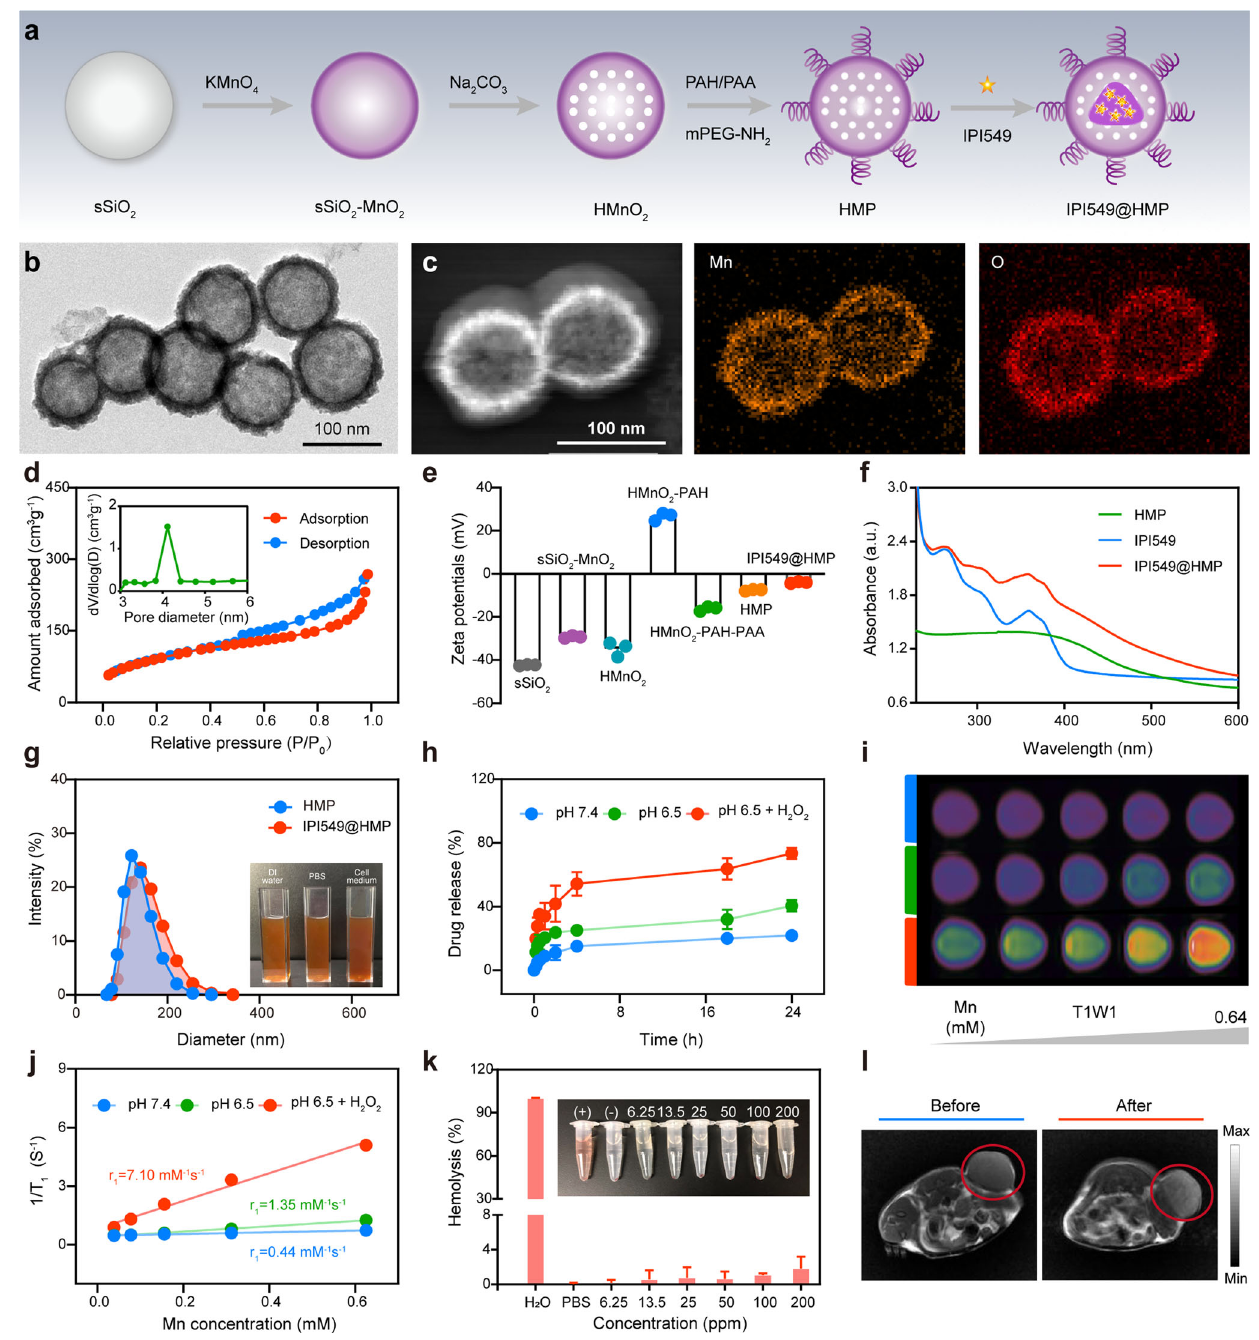
Fig. 3 Schematic and characterization of HMP-based nanoplatform. a A scheme indicating the step-by-step synthesis of HMP nanoparticles and the subsequent drug loading. b The representative TEM image of HMP nanoparticles from three independent samples. c The representative HAADF-STEM image and corresponding elemental mappings of HMP nanoparticles from three independent samples. d The representative N 2 absorption-desorption isotherms and pore size distribution (inset) of HMnO 2 nanoparticles from three independent samples. e Zeta potential variations in the preparation procedure of IPI549@HMP nanoparticles. Data were expressed as means ± SD ( n = 3 independent samples). f Representative UV-vis spectrums of free IPI549, HMP and IPI549@HMP from three independent samples. g Representative particle-size distributions of HMP and IPI549@HMP from three independent samples (Inset: digital photos of IPI549@HMP dispersed in deionized water, PBS and cell culture medium). h Cumulative release kinetics of IPI549 from HMP in varied conditions. i Representative T 1 -weighted MR images of different concentrations of IPI549@HMP dispersed in varied conditions from three independent samples. j Representative relaxation rate r 1 versus Mn 2 + concentrations when dispersed in varied conditions from three independent samples. k Concentration-dependent hemolysis and relative digital photo (inset) of IPI549@HMP. Data were expressed as means ± SD ( n = 3 independent samples). H 2 O and PBS were set as positive and negative control, respectively. l Representative T 1 -weighted MR images of CT26 tumor- bearing mice before and after IPI549@HMP intravenous injection from three biologically independent samples. The red circle indicates tumor tissue. Source data are provided as a Source Data fi